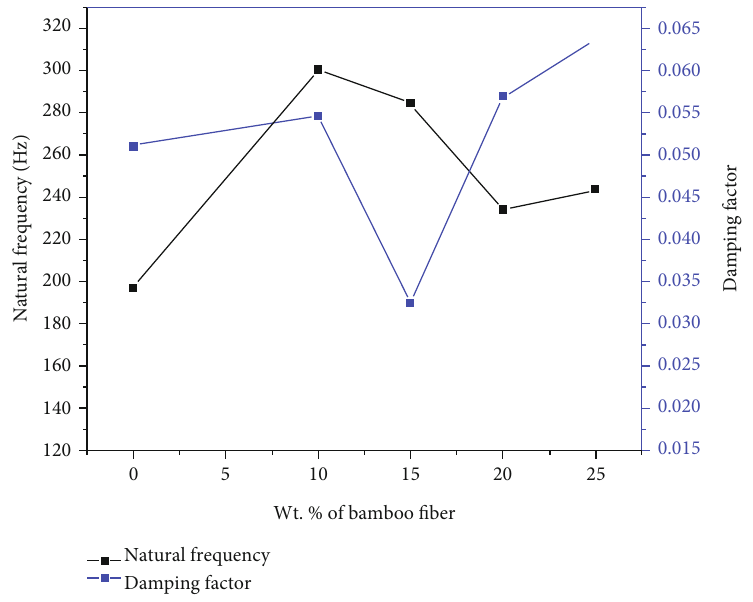
Figure 7: Natural frequency and damping factor with varying bamboo fi ber wt.% (mode 2)